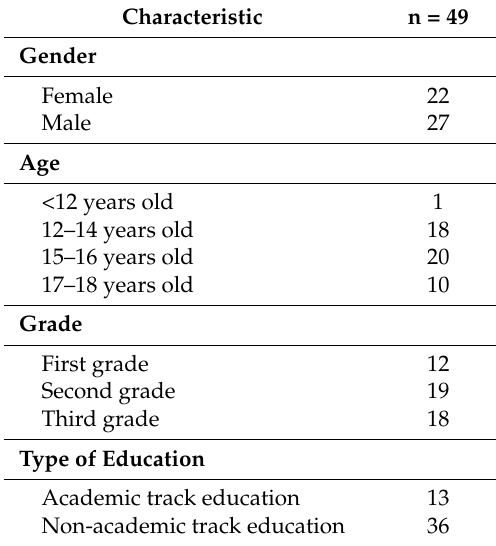
Table 1. Characteristics of participating